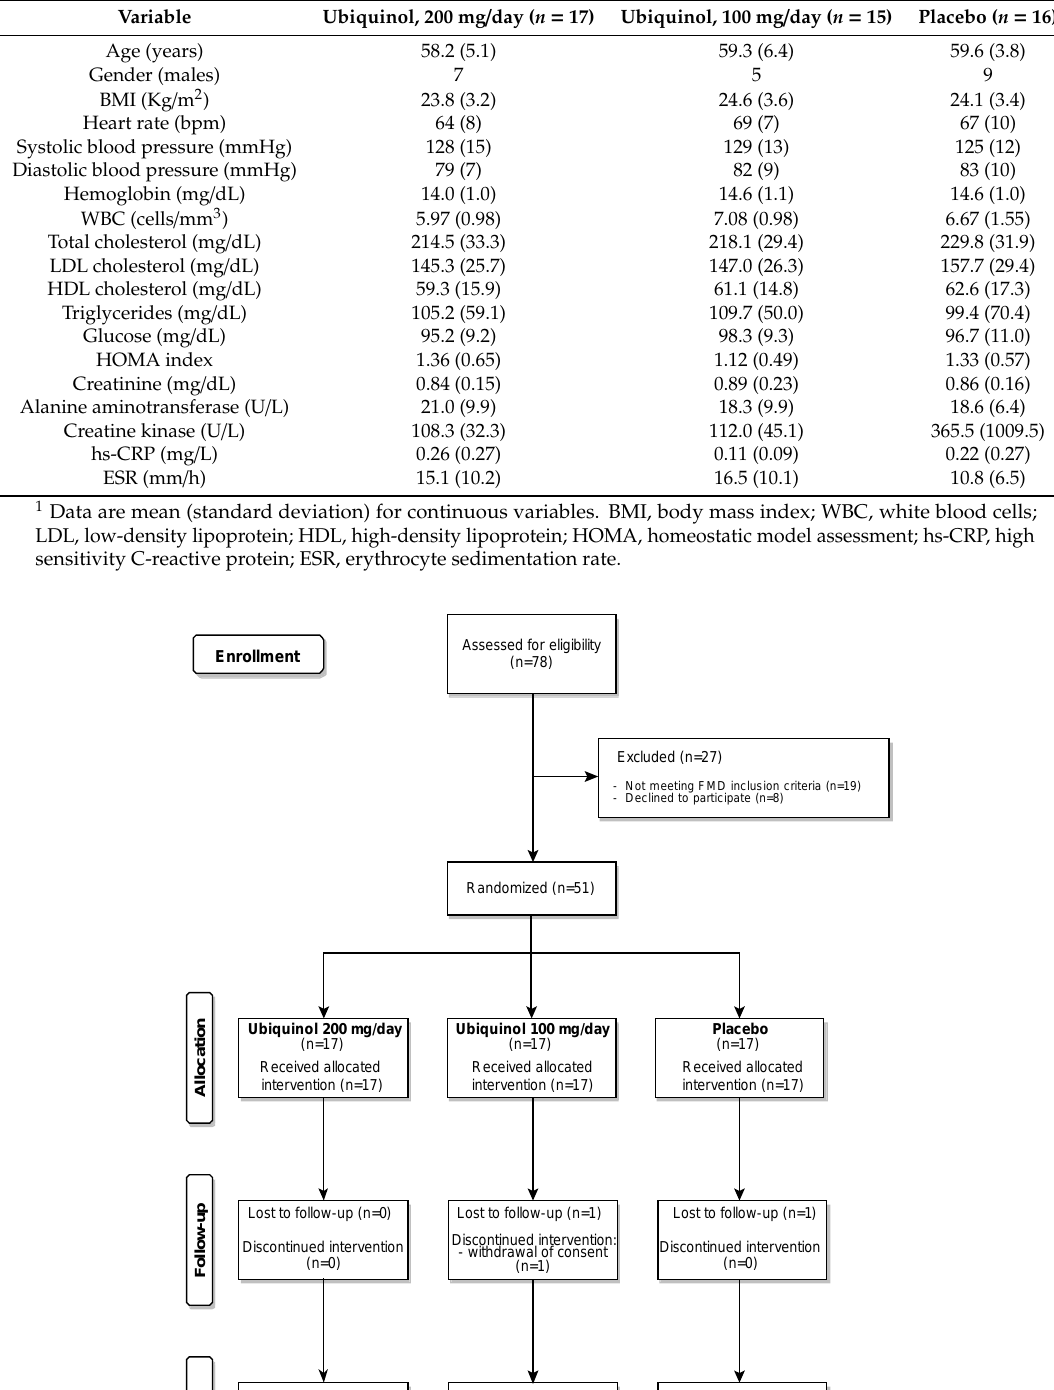
Table 1. Baseline clinical and demographic characteristics of the 48 subjects in the per-protocol population 1 .